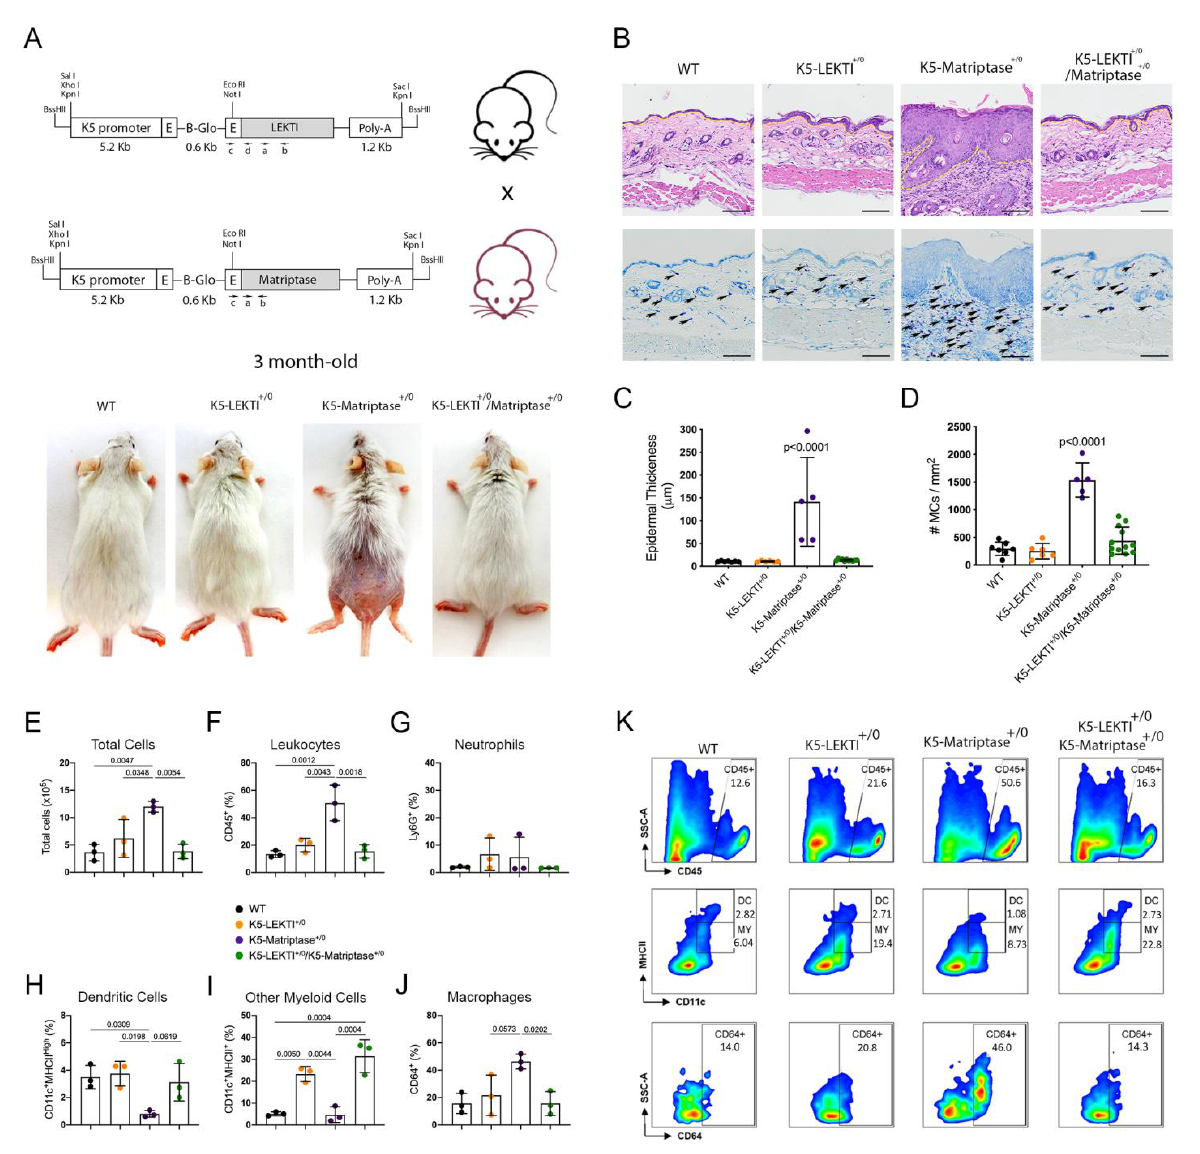
Figure 3. Co-expression of LEKTI attenuates matriptase-mediated premalignant skin phenotype. ( A ) The scheme shows the breeding of K5-LEKTI +/0 with K5-Matriptase +/0 mice and the resulting litter of WT, K5-LEKTI +/0 , K5-Matriptase +/0 , and K5-Matriptase +/0 /K5-LEKTI +/0 mice. Images show the outward appearance of these mice at 3 months of age. Matriptase- induced alopecia and ichthyosis are considerably attenuated by co-expression of LEKTI in Matriptase +/0 /K5-LEKTI +/0 . LEKTI +/0 in 3-month-old mice. ( B ) Representative histological appearance of dorsal skin of littermate WT (first column), K5-LEKTI +/0 (second column), K5-Matriptase +/0 (third column), and K5-Matriptase +/0 /K5-LEKTI +/0 mice (forth column) stained by H&E (top panels) and Toluidine Blue (bottom panels) at 3 months of age. Bars = 100 µ m. Yellow dashed lines show the limits between epidermis and dermis. Black arrows show metachromatically stained dermal mast cells. ( C ) Quantification of epidermal thickness in littermate WT ( n = 7, black dots), K5-LEKTI +/0 ( n = 6, orange dots), K5- Matriptase +/0 ( n = 5, purple dots), and K5-Matriptase +/0 /K5-LEKTI +/0 ( n = 11, green dots) at 3 months of age˙ Data